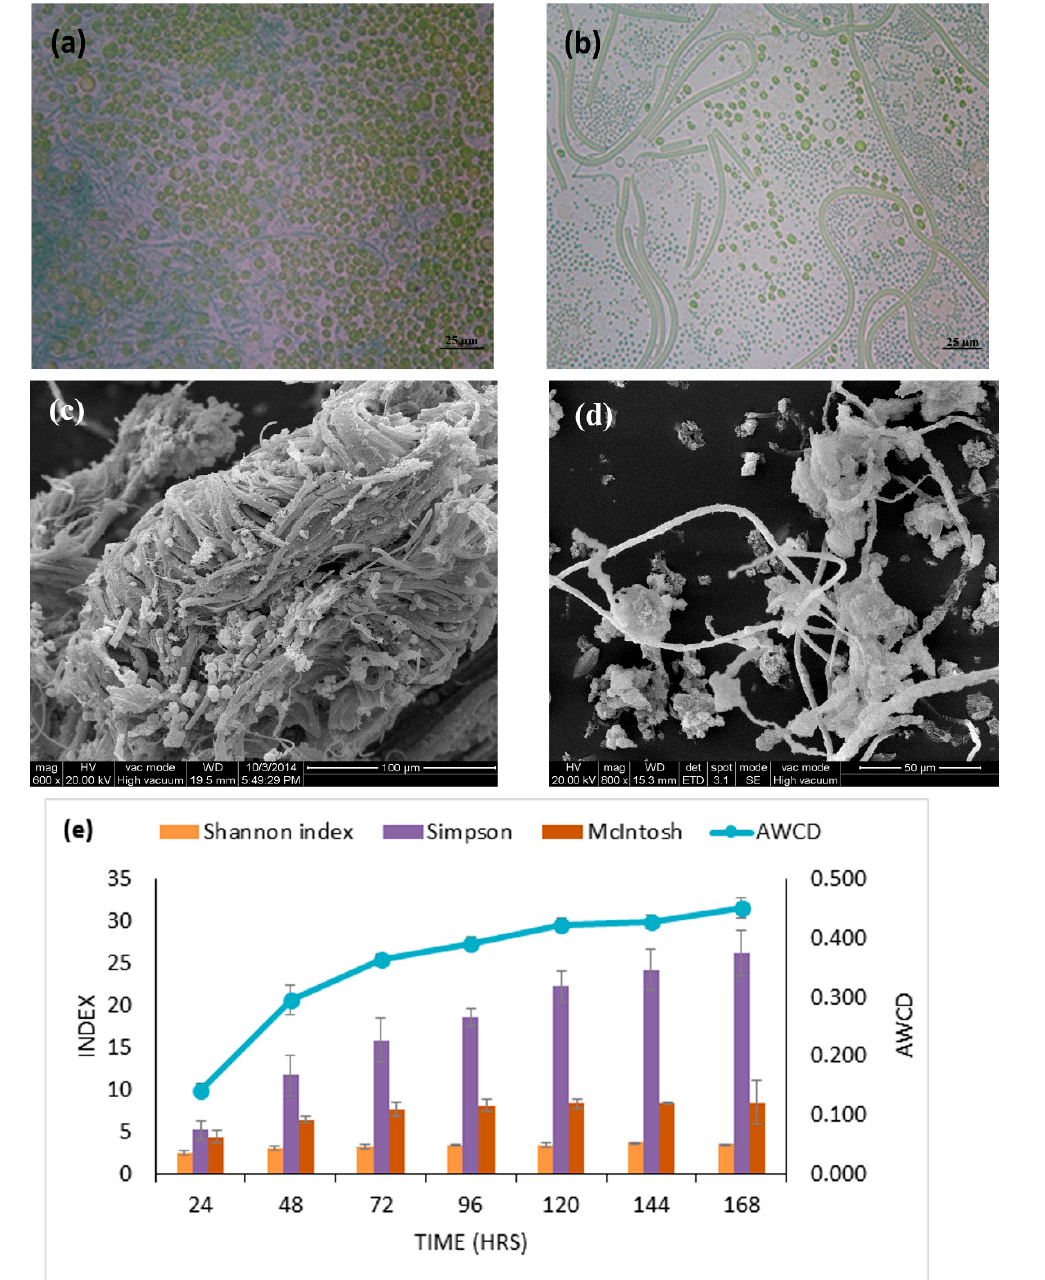
Figure 1. Phase Contrast Microscopy (PCM) and Scanning Electron microscopy (SEM) were performed to differentiate microbial community change ( a ) and ( b ) community composition of epipelon observed under PCM before and after 12% methane treatment, respectively. ( c ) and ( d ) structure of periphytic biofilm observed under SEM before and after 12% methane treatment, respectively. ( e ) The average well color development (AWCD) of the Biolog EcoPlates at 590 nm for periphytic biofilm and diversity indices (E) for species